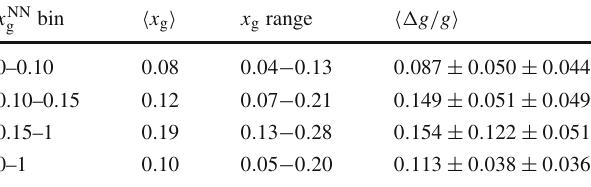
Table 2 The values for (cid:2) (cid:3) g / g (cid:3) in three x NN g bins, and for the full x g range. The x g range given in the third column corresponds to an interval in which 68% of the MC events are found